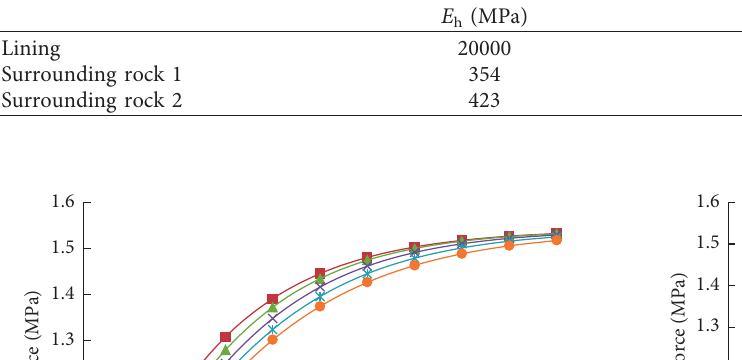
Table 1: Generalized Kelvin model parameters.